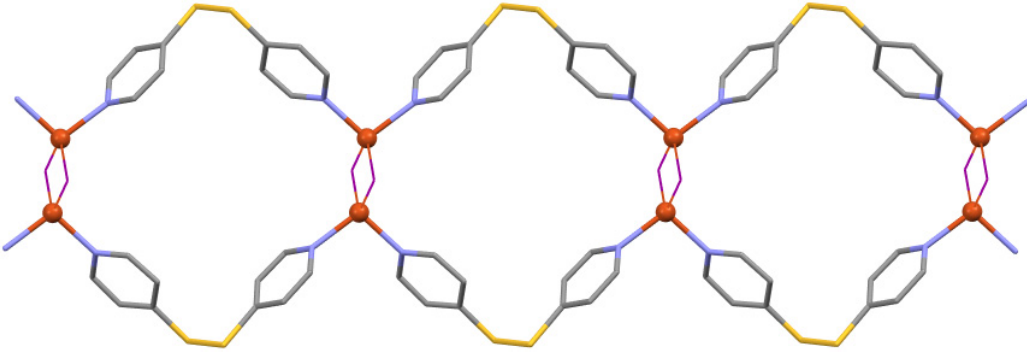
Figure 29. Coordination polymer strand in [CuI( μ - dtdp )·CH an achiral repeated rhomboid